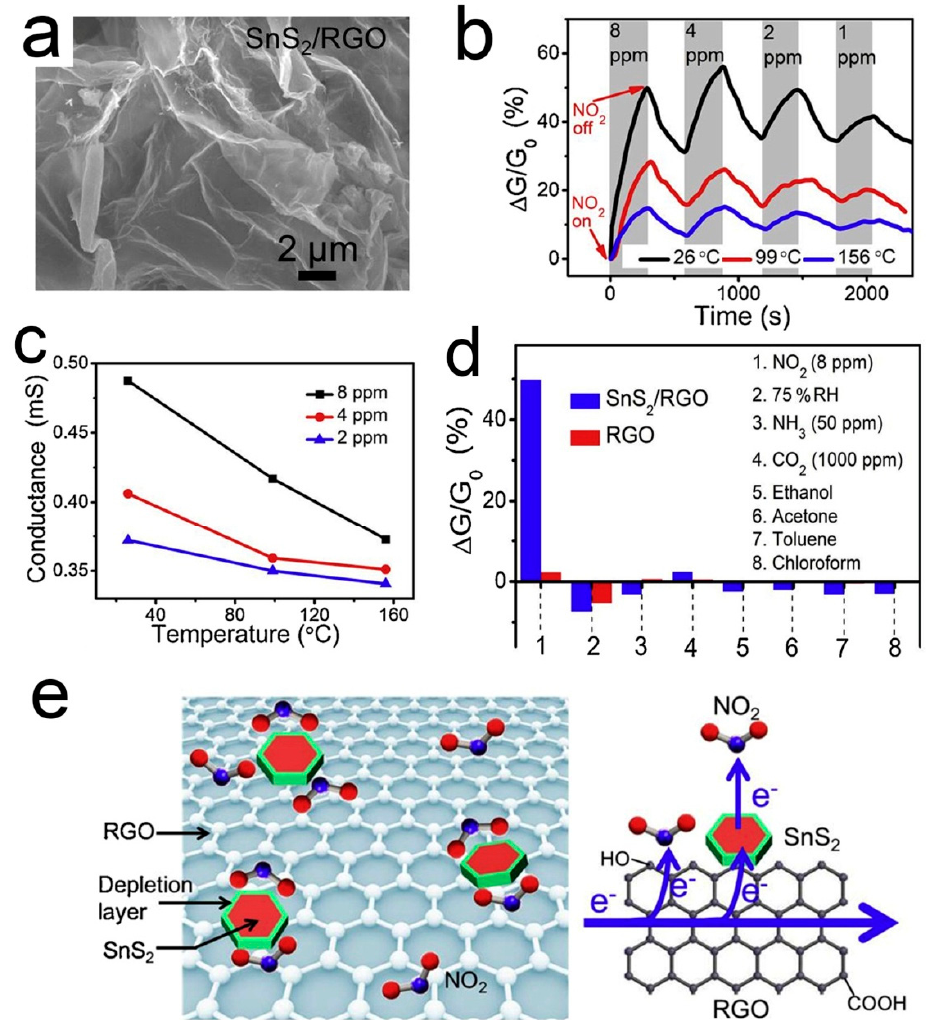
Figure 3. ( a ) SEM image of 3D SnS 2 /RGO; ( b ) Dynamic responses of SnS 2 /RGO to NO 2 ; ( c ) Conductance variation of SnS 2 /RGO versus operation temperature; ( d ) RT sensing responses of SnS 2 /RGO and RGO; ( e ) Schematic illustration of the NO 2 sensing mechanism of the SnS 2 /RGO sensor